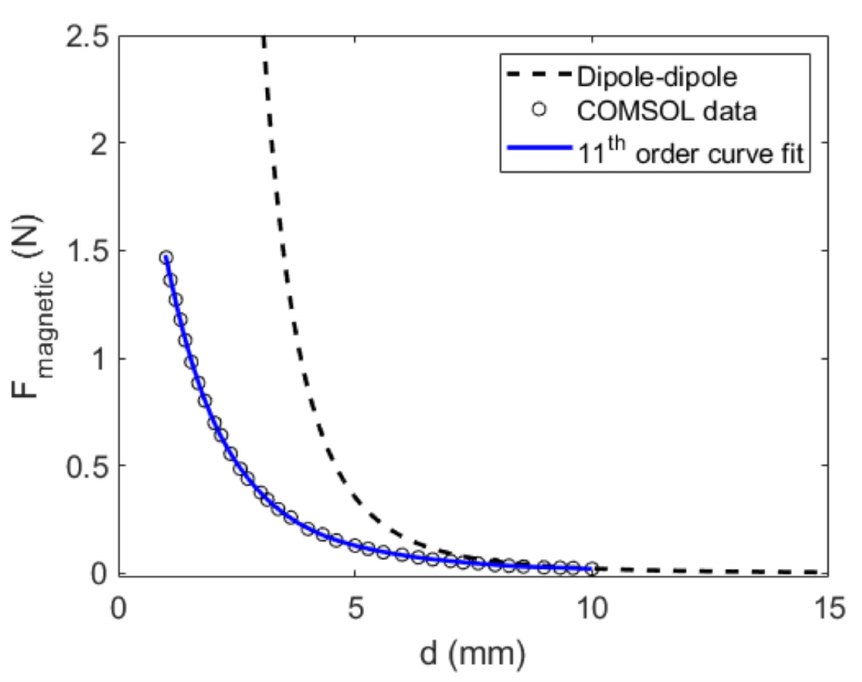
Figure 2. A comparison between the dipole–dipole approximation and the COMSOL data